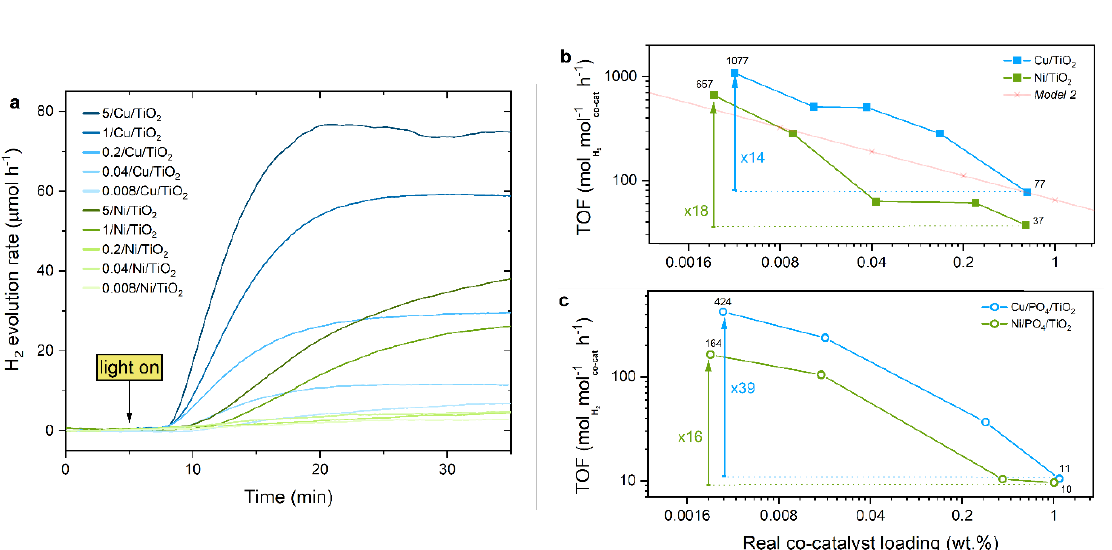
Figure 6. Photocatalytic performance: ( a ) Exemplary HER profiles for Cu/TiO 2 and Ni/TiO 2 series and ( b ) real co-catalyst loadings against maximum HER-activity per mol co-catalyst (expressed in TOF values) for TiO 2 and ( c ) PO 4 /TiO 2 series. Red dashed line represents the Model 2 fit (see Appendix).